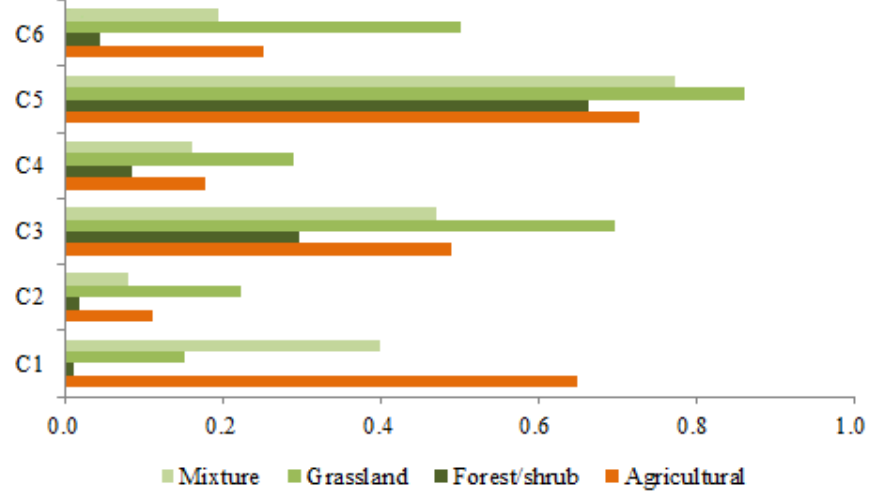
Figure 3. Comparison of the C factors (C1–C6) obtained for the different land cover types. C1–C6 represent the six C factor estimation methods shown in Table 2.